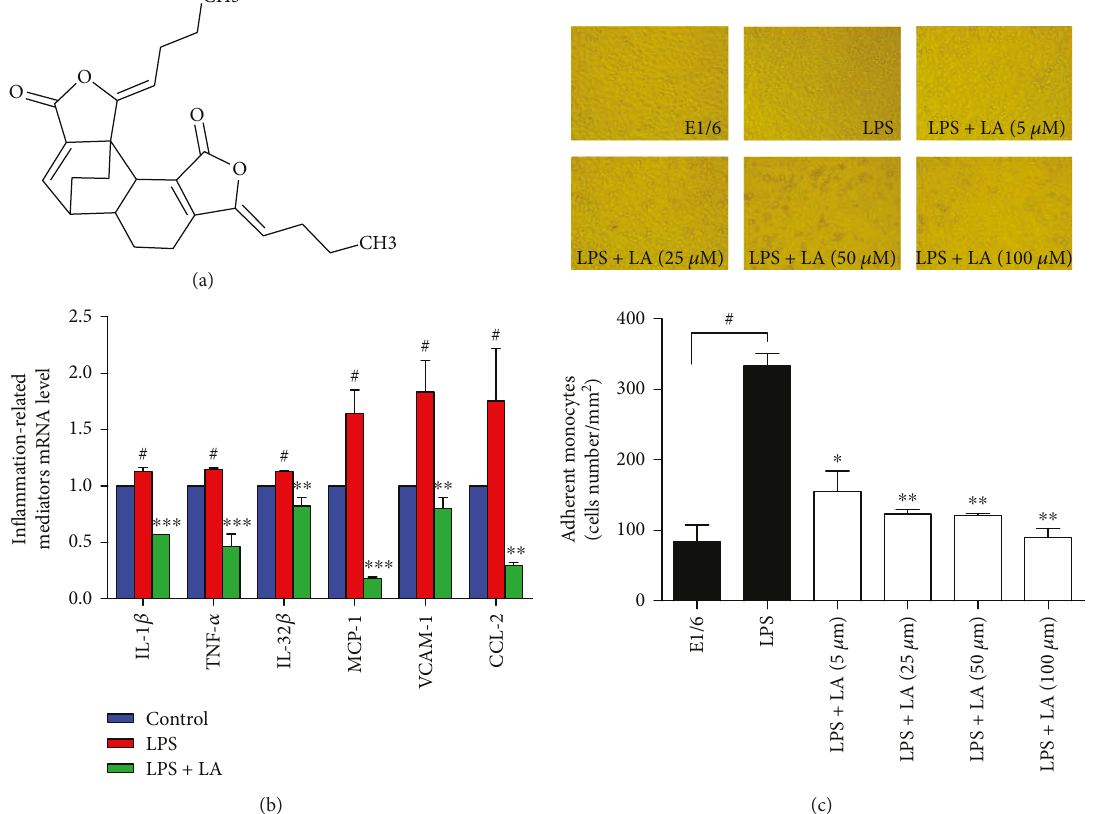
Figure 1: LA inhibited the mRNA levels of LPS-induced proin fl ammatory mediators and inhibited the adhesion of monocytes to HUVECs. The molecular structure of LA (a). HUVECs were pretreated with 50 μ M of LA for 60min before treatment with LPS (100ng/mL) (b) for 6h. Expression of IL-1 β , TNF- α , IL-32 β , MCP-1, CCL-2, and VCAM-1 mRNA levels were measured using RT-PCR. HUVECs were pretreated with a blocking mouse antihuman monoclonal antibody (E1/6) against VCAM-1 or various doses of LA for 60 min before treatment with LPS. U937 mononuclear cells adhered to LPS-stimulated HUVECs were observed through microscopic images (c). Data represent the mean ± SD of at least three independent experiments, and each experiment was performed in triplicate. # p < 0 05 versus control; ∗ p < 0 05 versus LPS; ∗∗ p < 0 01 versus LPS; ∗∗∗ p < 0 001 versus